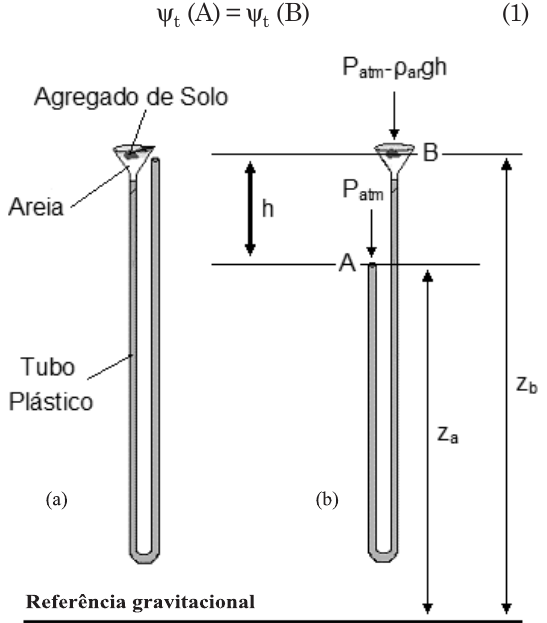
Figura 1. Esquema do funil de Haines modificado: (a) saturação e (b) tensão h